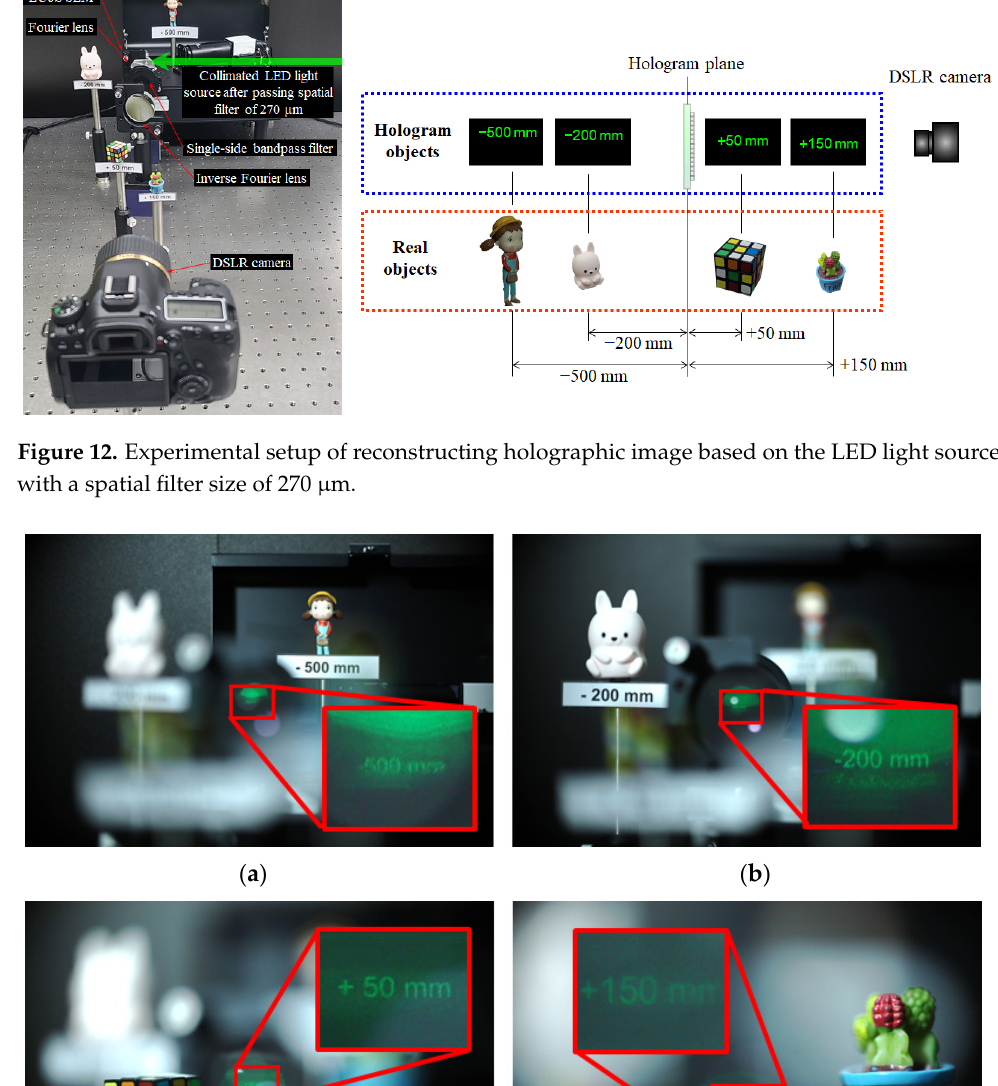
Figure 11. Optimal spatial filter size realized by DMD in experimental configuration.